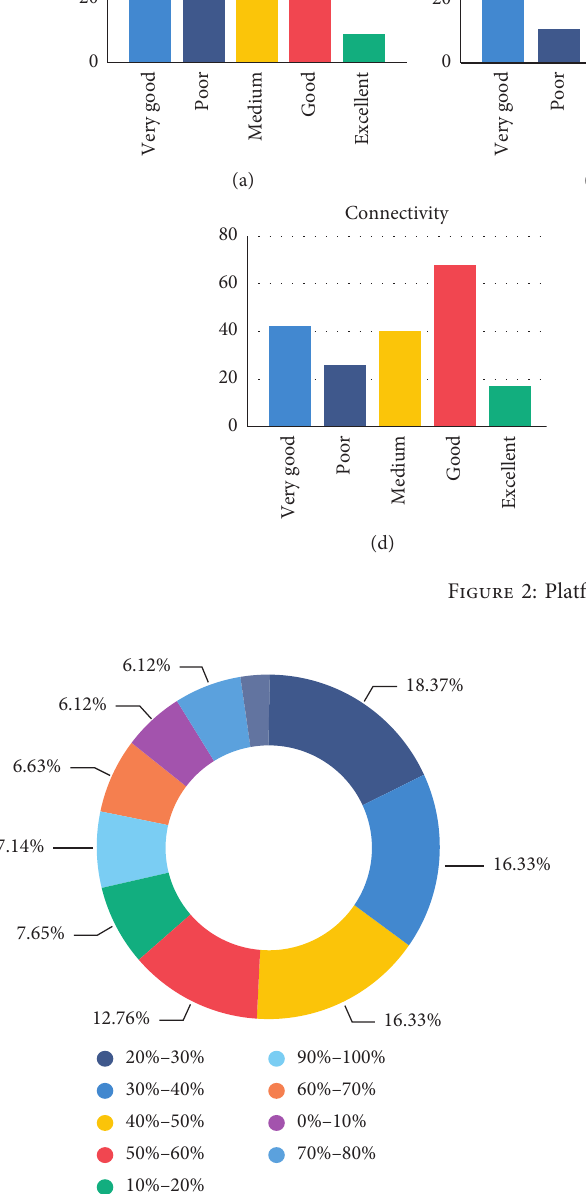
Figure 3: Course rates that can be provided remotely.